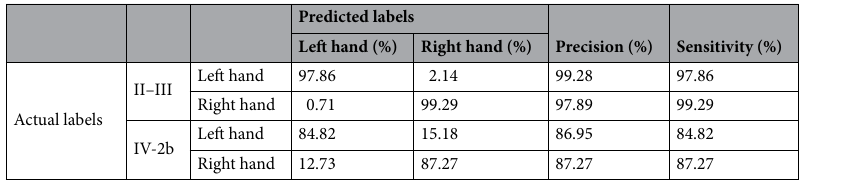
Table 6. Confusion matrix for fusion